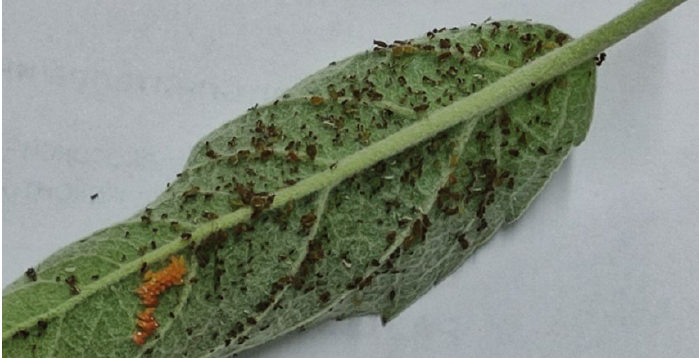
Figure 3. In vivo action of Panatop Immuno Active+ towards Aphis